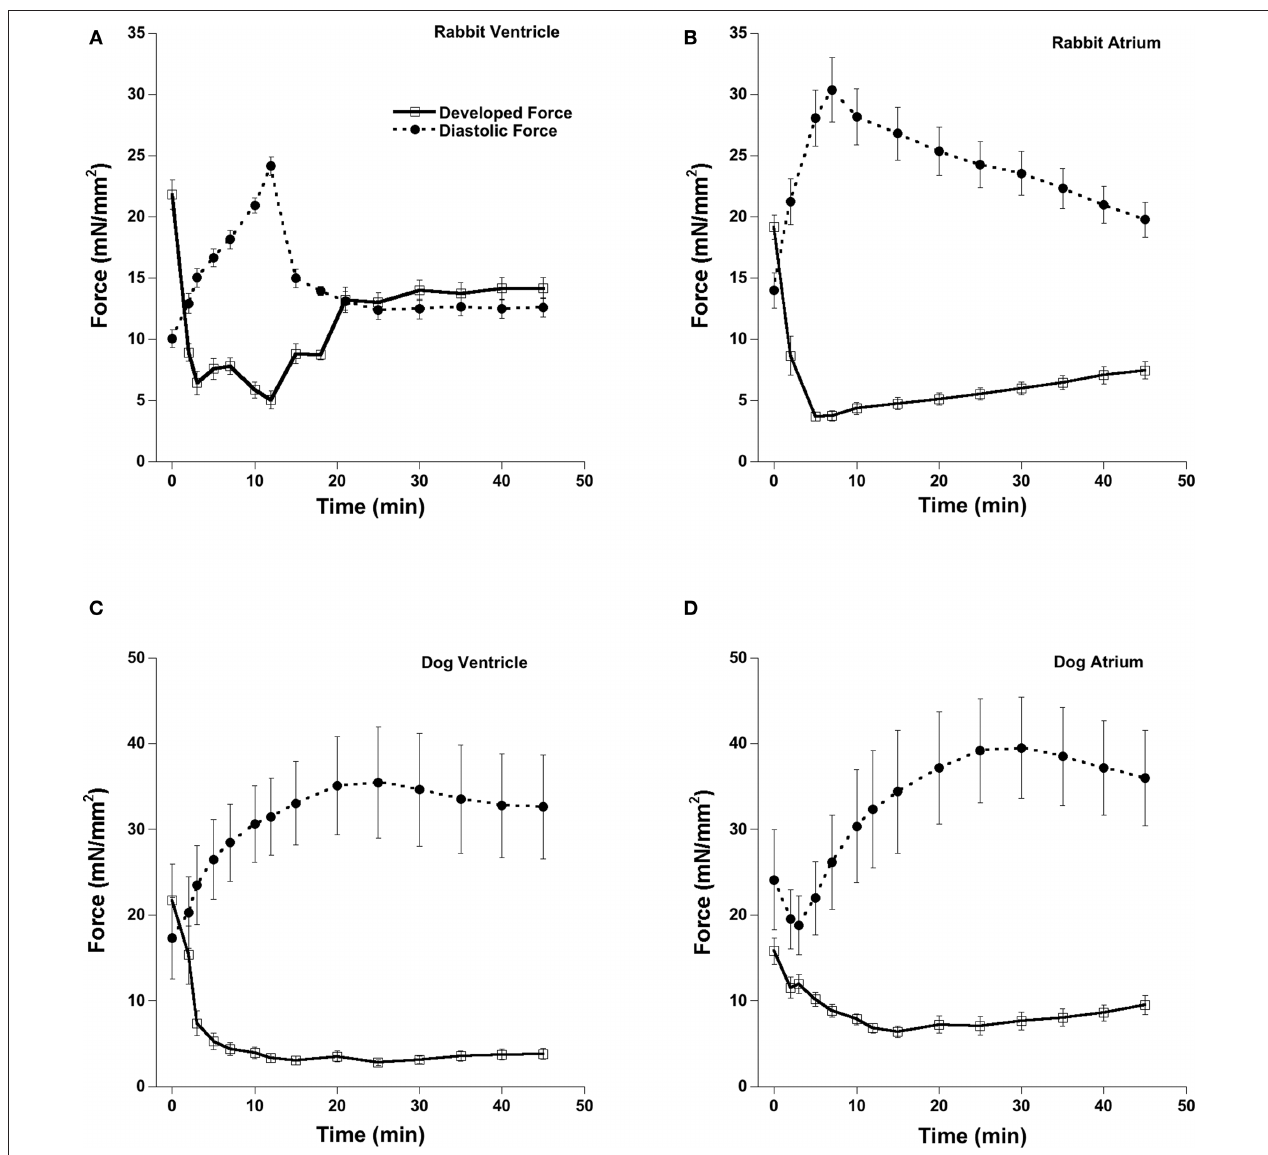
FiguRe 2 | effect of 2-min exposure of OH-radicals on the contractile parameters of the cardiac trabeculae. At peak of contracture there is a significant increase in diastolic force and a significant decrease in developed force. After 45 min, parameters started to level off, and this state was marked by